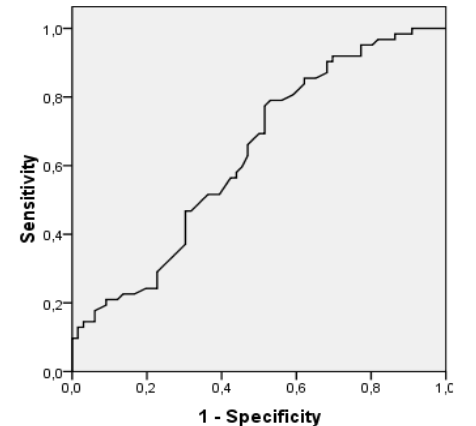
ROC curve for HFpEF + CAD + diastolic dysfunction in HTN ( n = 30) and CON ( n = 2) Figure 8. ROC curves for predictive performance of GLS for HFpEF. Figure 8. ROC curves for predictive performance of GLS for